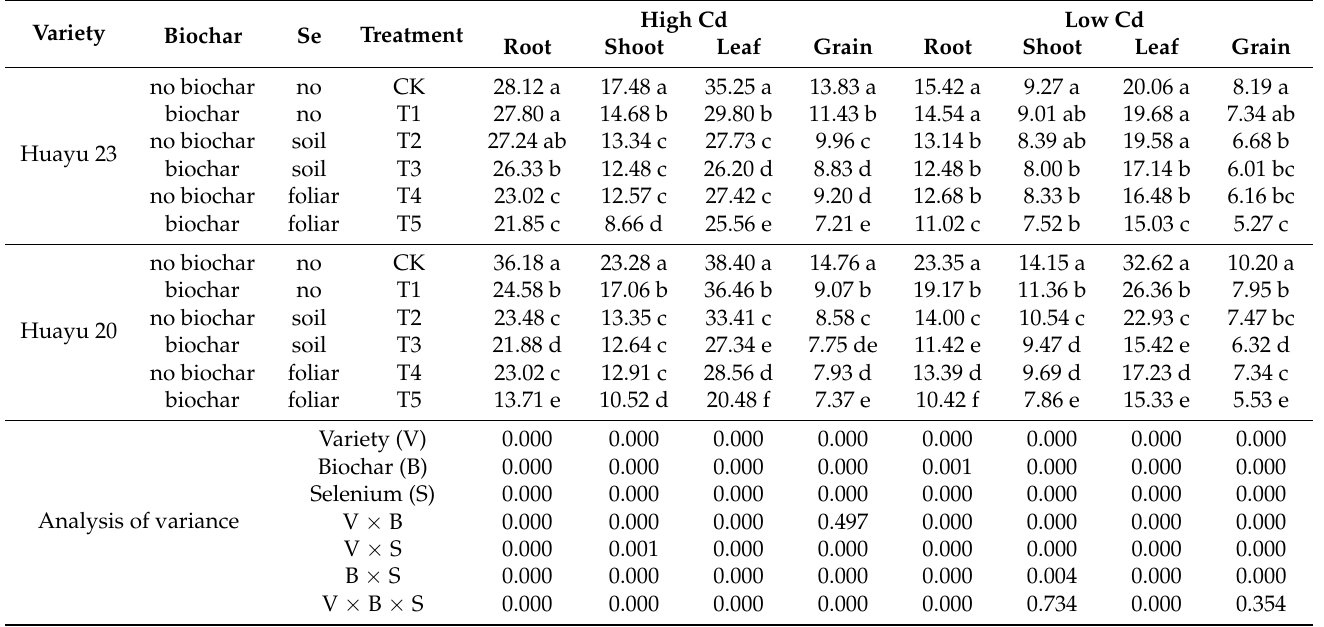
Table 2. Cadmium content (mg · kg − 1 ) in the roots, stems, leaves, and grains of Huayu 23 and Huayu 20 under different